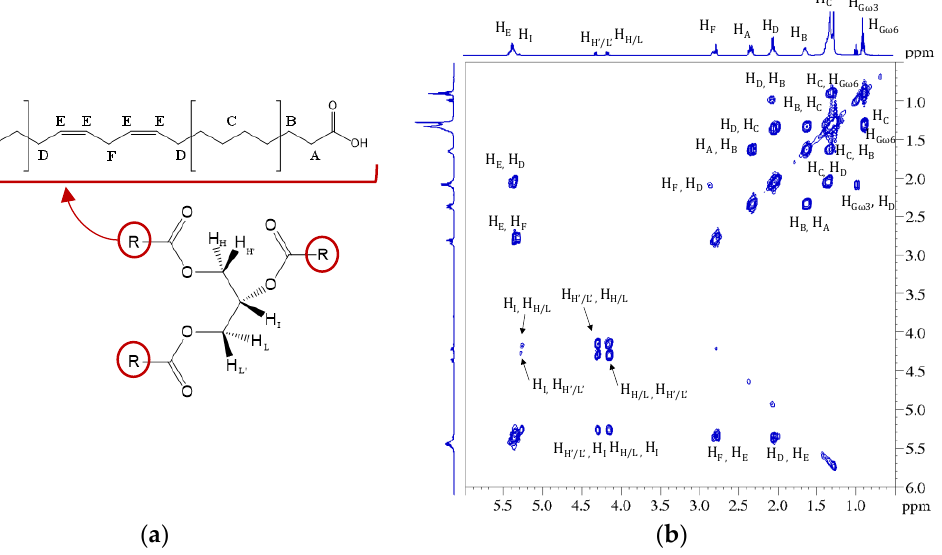
Figure 4. ( a ) General structure and nuclei labelling of molecular fragments in triacylglicerols (TAGs); ( b ) 2D map 1 H COSY of the ethanolic extract with the UAE of C. sativa seeds. In the figure, all cross peaks corresponding to the homuncular correlations have been highlighted.